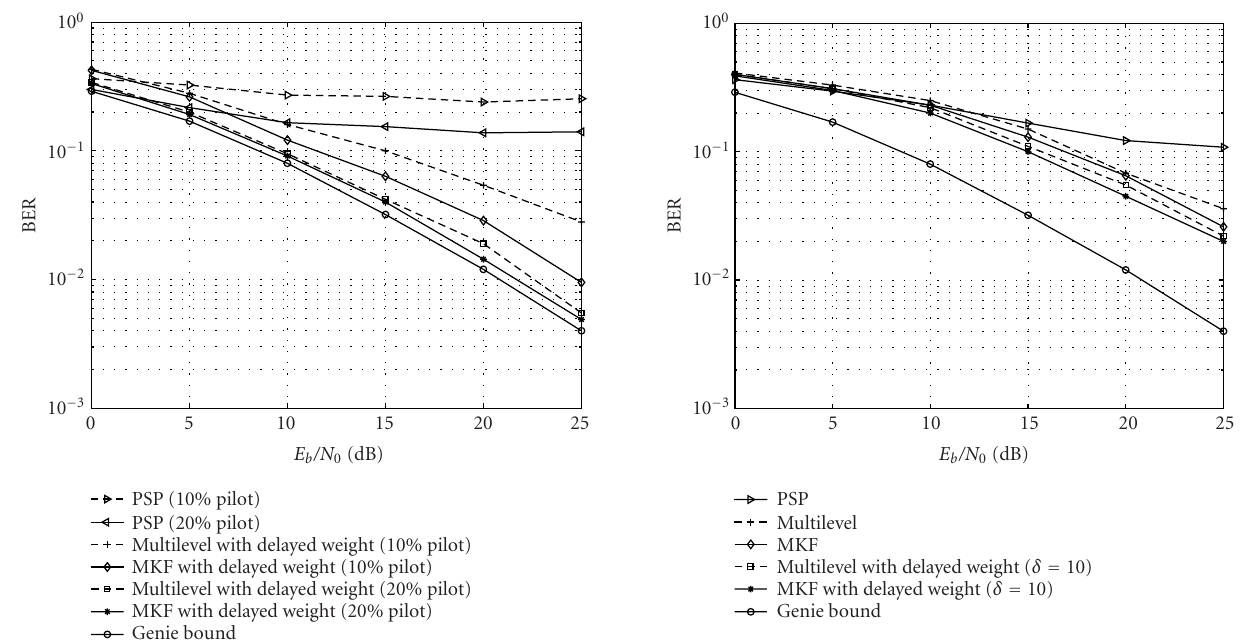
delayed multilevel MKF based on the second-level sampling space A 2 is nearly 2 dB better than that based on the third- level sampling space A 3